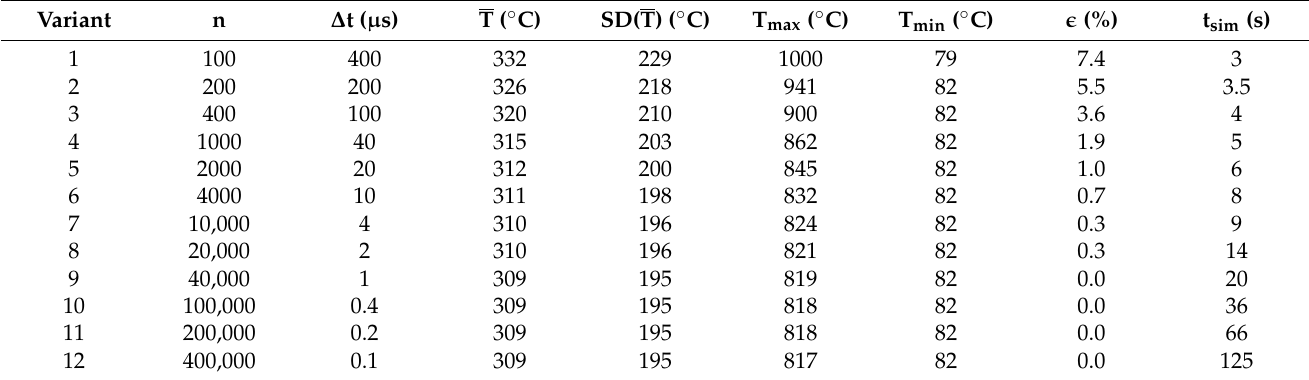
Table 3. Characterization of sheet temperature field depending on (n, ∆ t)-variants (welding time t w = 40